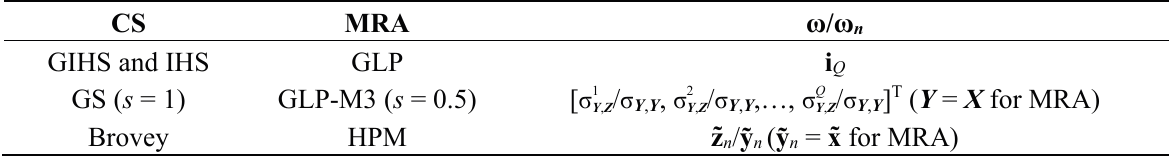
Table 1. The corresponding modulation coefficients for the different component substitution (CS) and multi-resolution analysis (MRA)